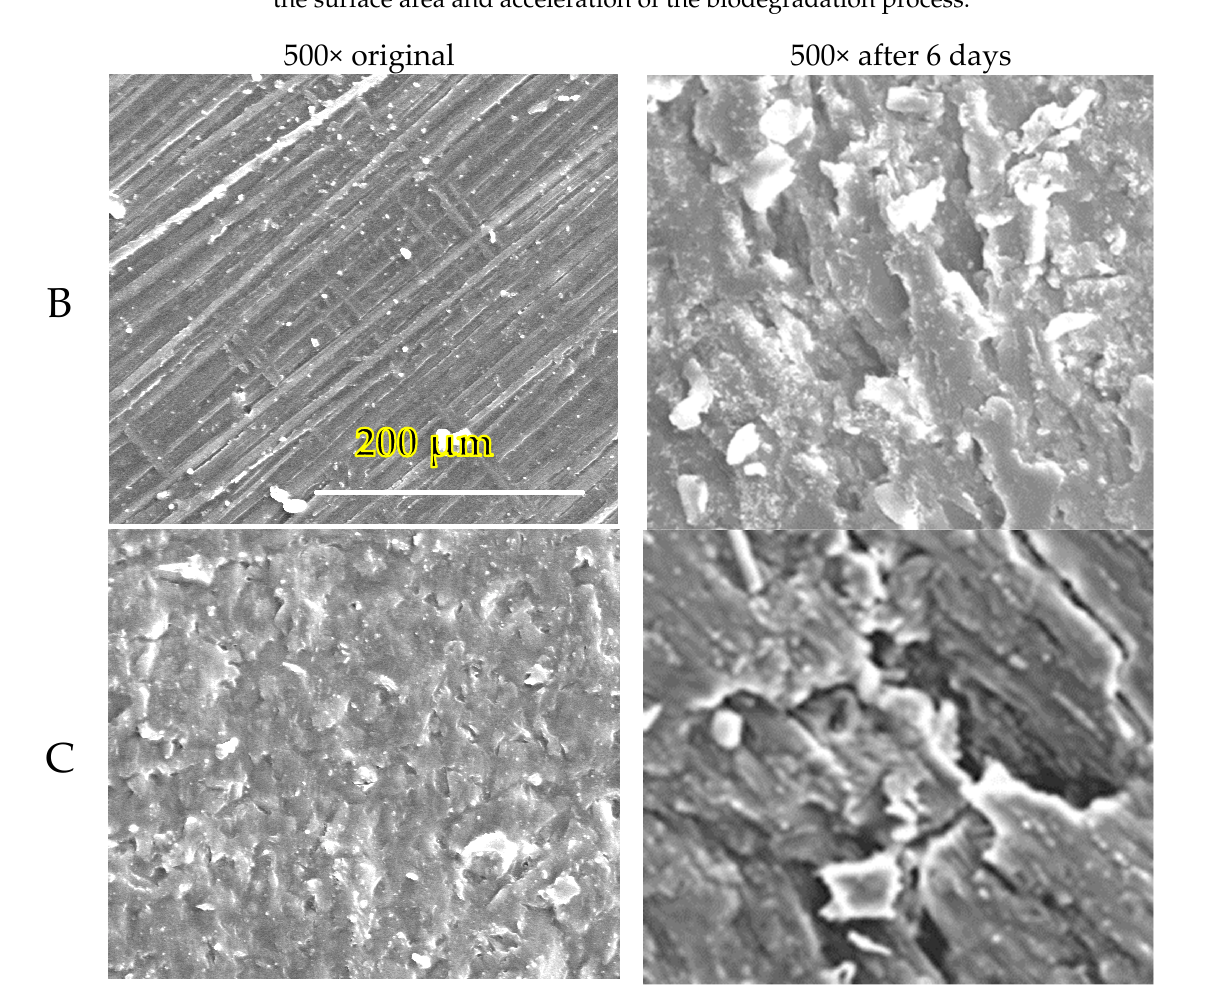
Figure 8. SEM images of the tested samples before composting and after 6 days of incubation in an electric composter. Specifications according to Table 2. (B—500 mL cup and C—200 mL cup with